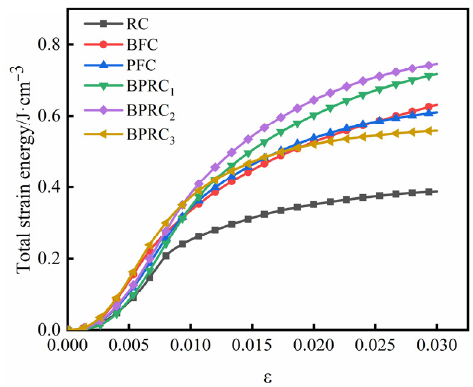
Figure 7. Total strain energy.